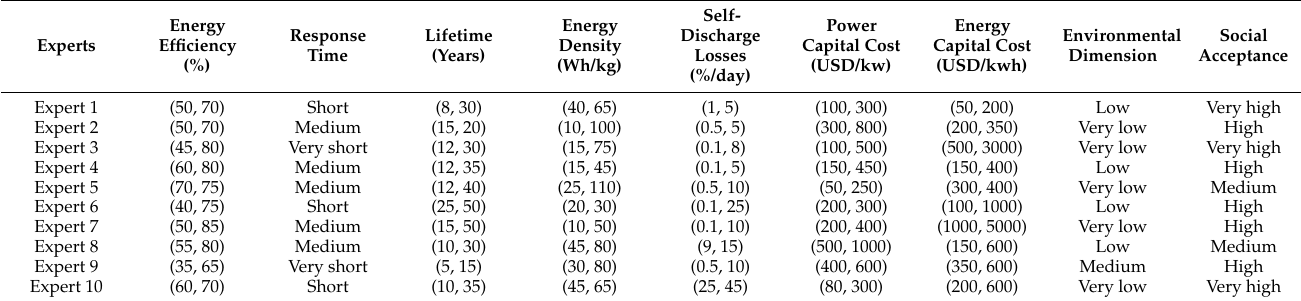
Table A23. The expert’s evaluation information in Scenario